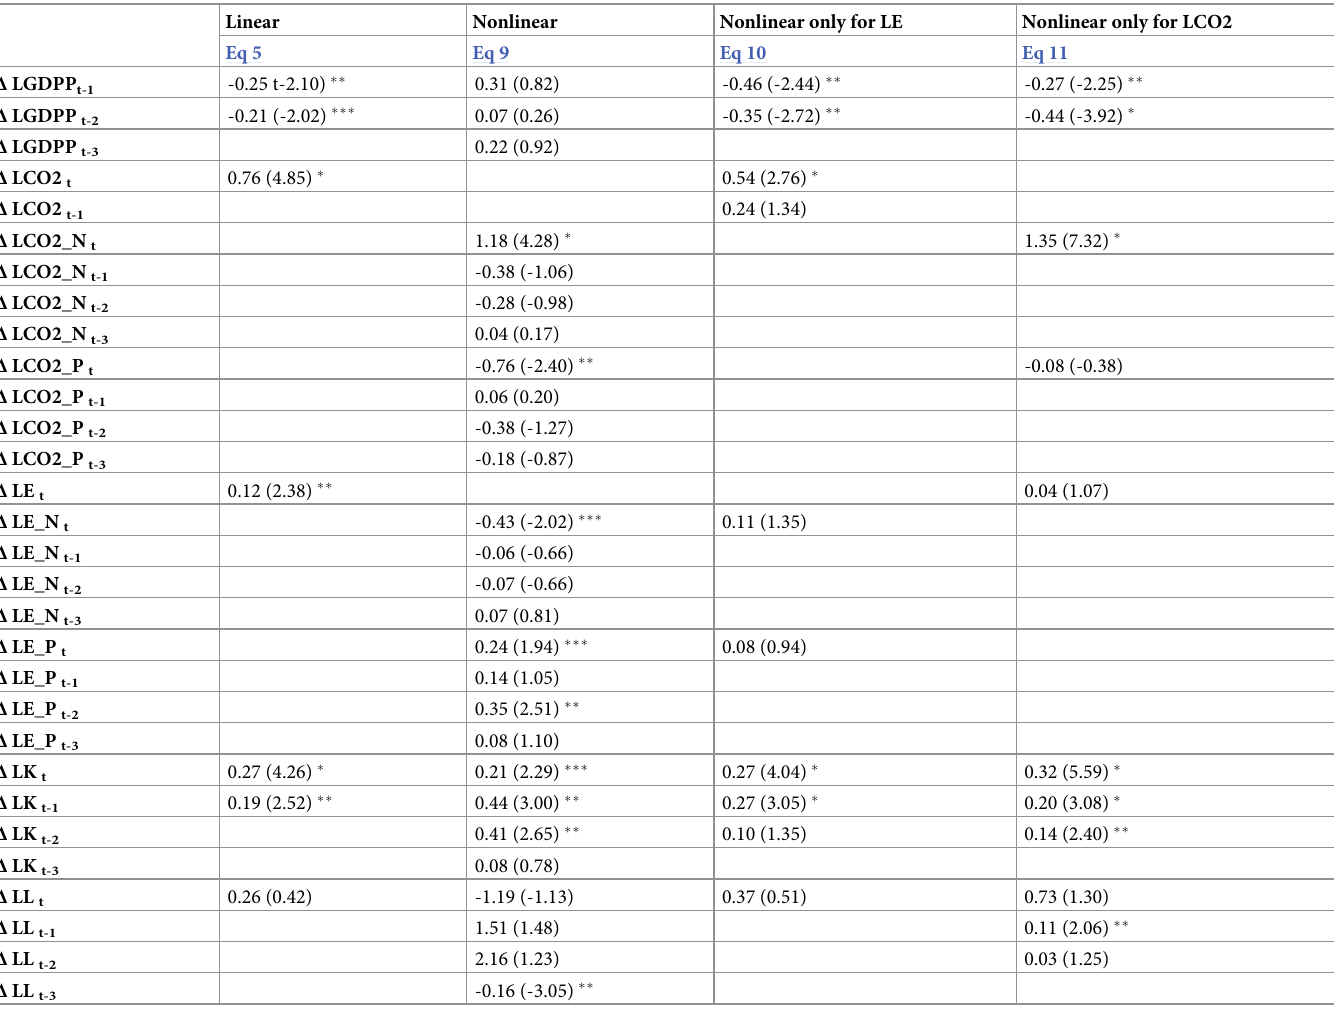
Table 4. Short-run coefficient estimates of linear and nonlinear ARDL